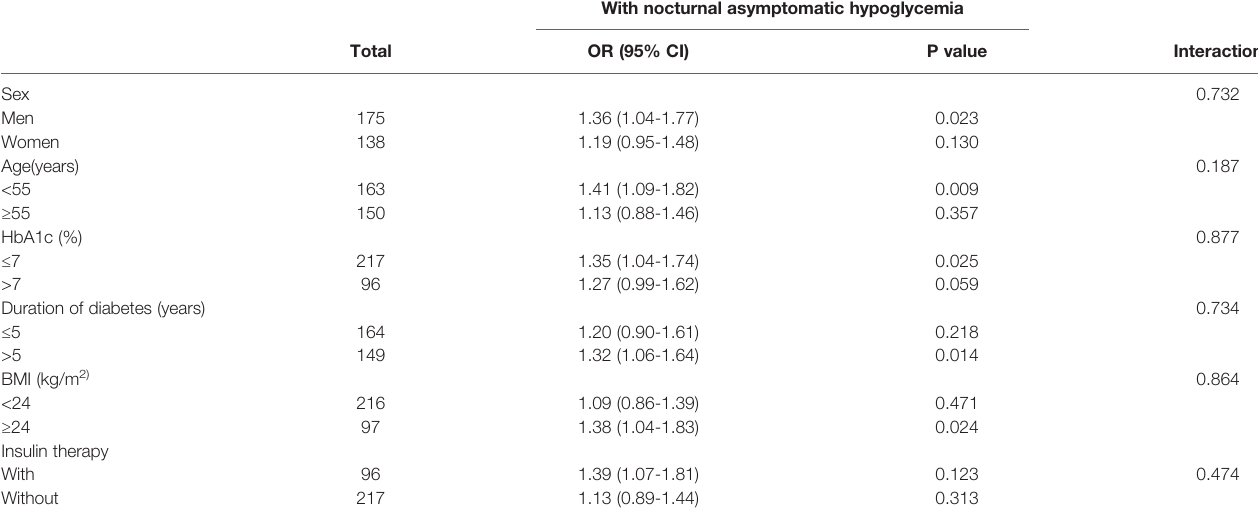
TABLE 3 | Association between LAGE and potential risk factors on the risk of